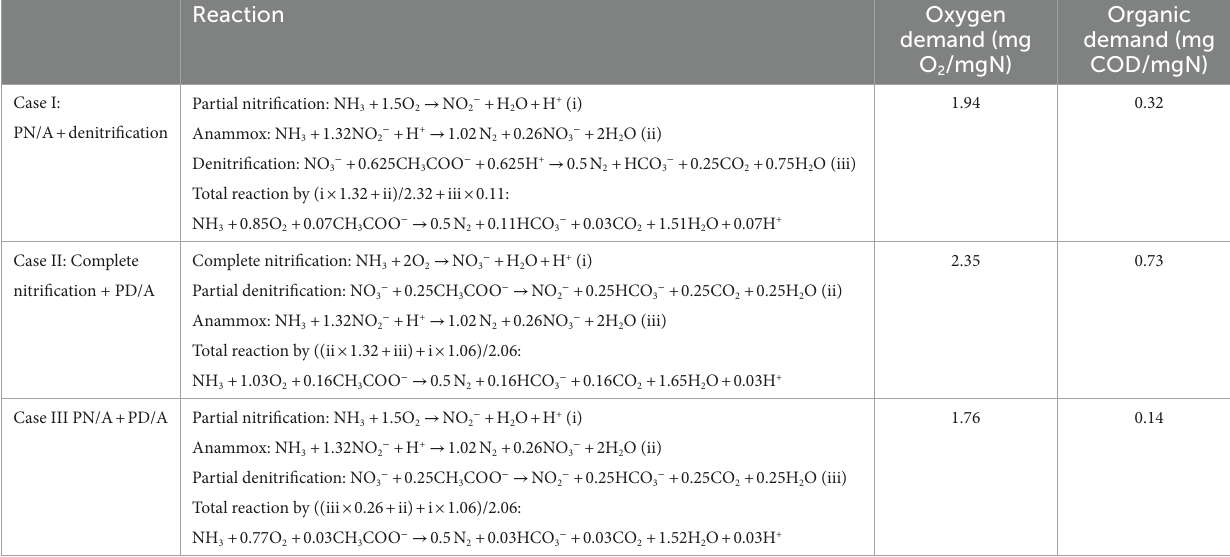
TABLE 2 Comparison of the theoretical oxygen and organic demand of different cases for complete nitrogen removal base on anammox.